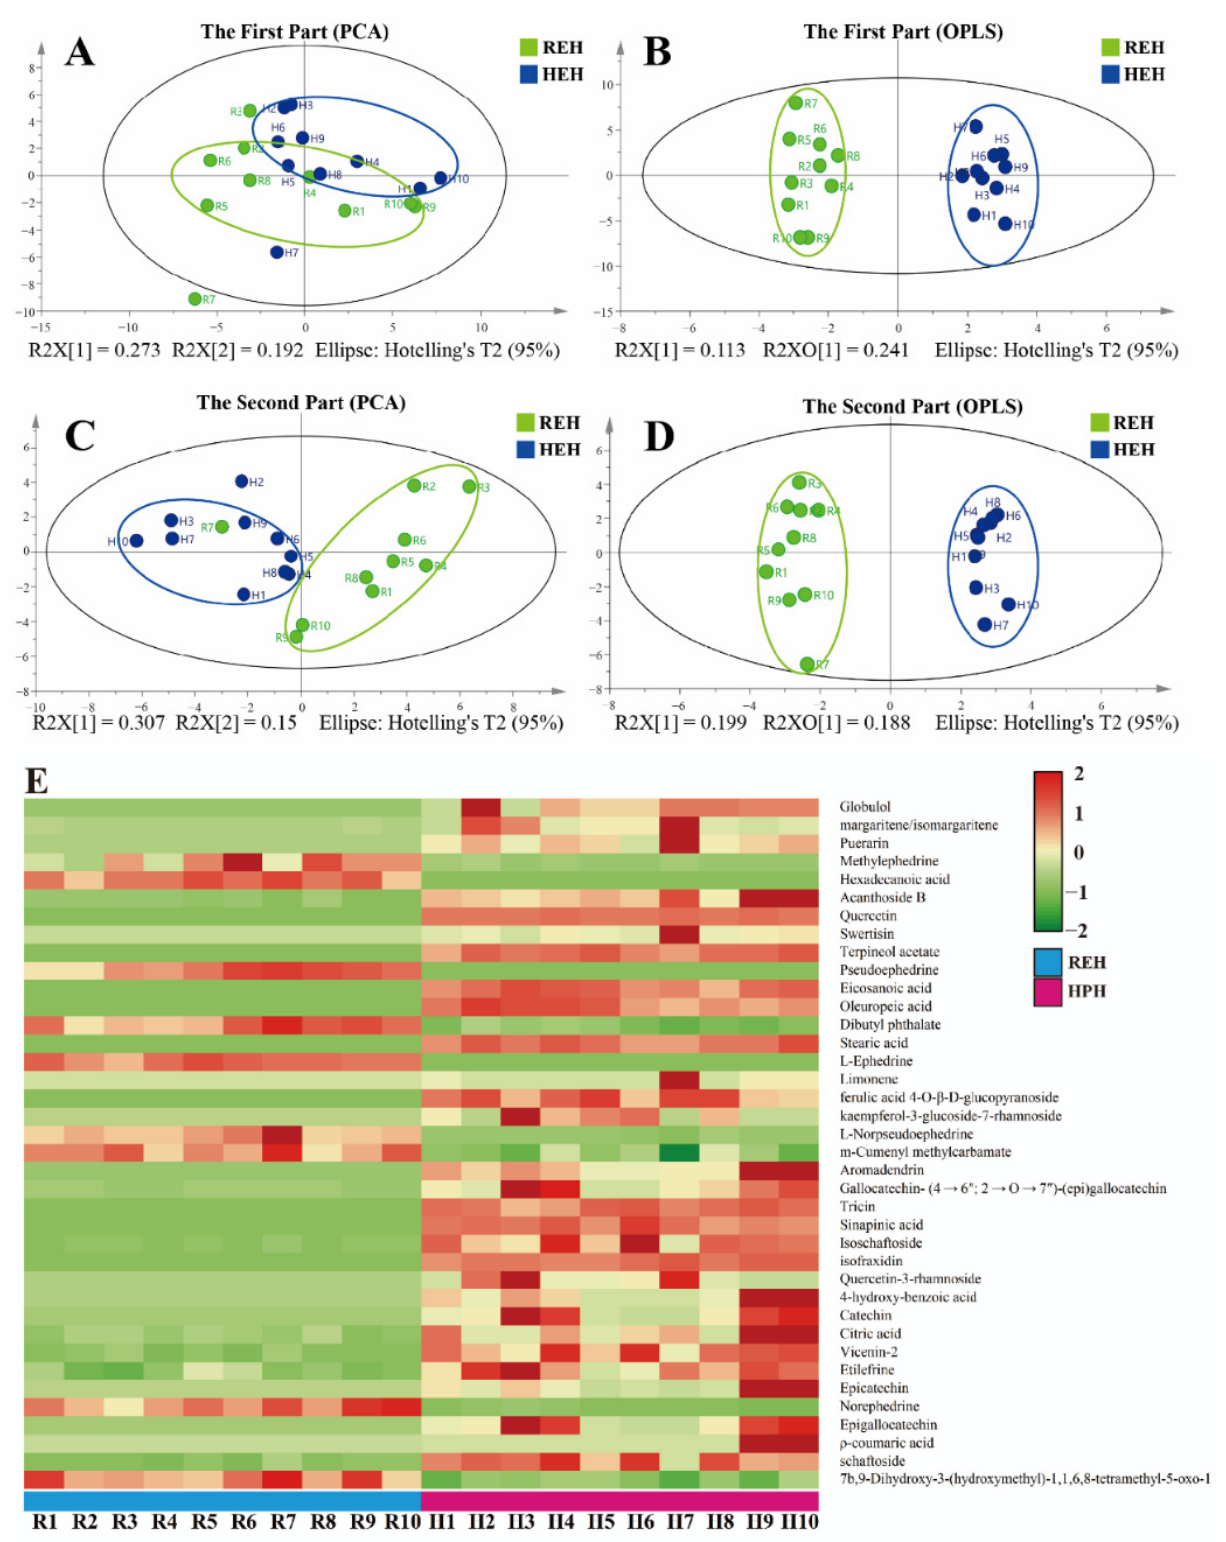
Figure 3. MVA plots of REH and HEH based on the MS spectral data generated in the positive mode. the PCA score plot with 95% density ellipses ( A , C ); the OPLS-DA score plot with 95% density ellipses ( B , D ); the heatmap of differential compounds related to REH and HEH ( E ).